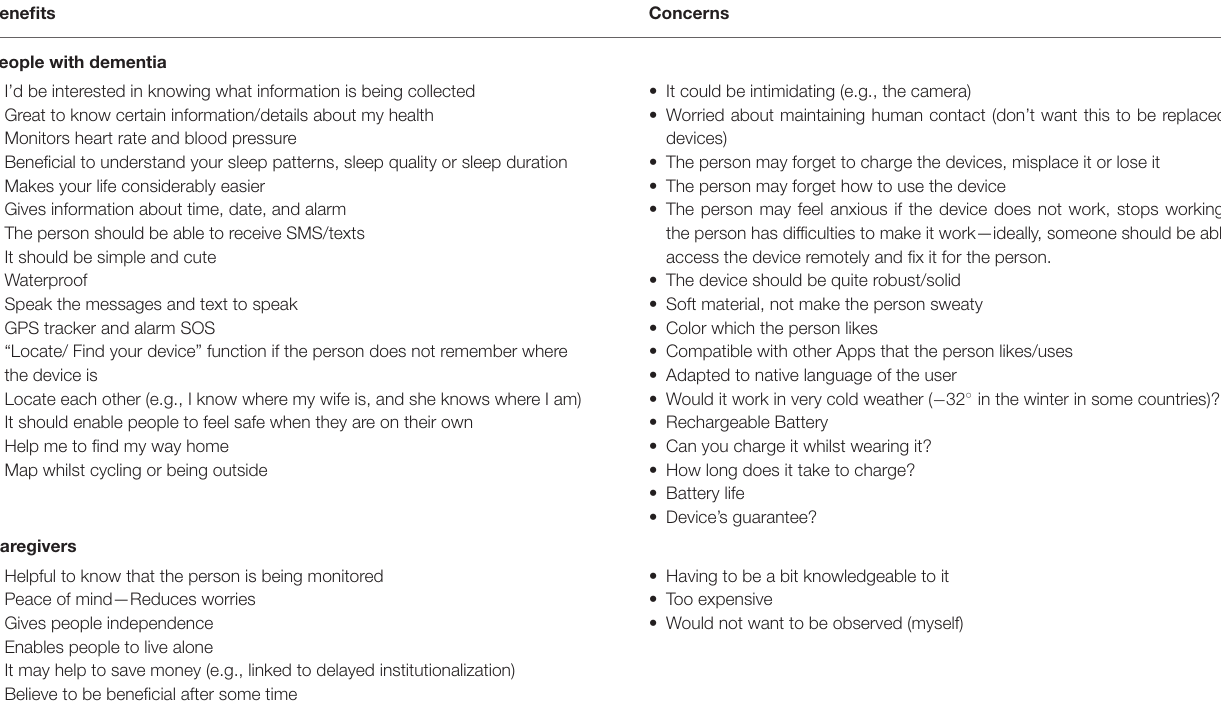
TABLE 2 | Open Questions and Feedback about potential benefits and concerns raised from people with dementia and caregivers.